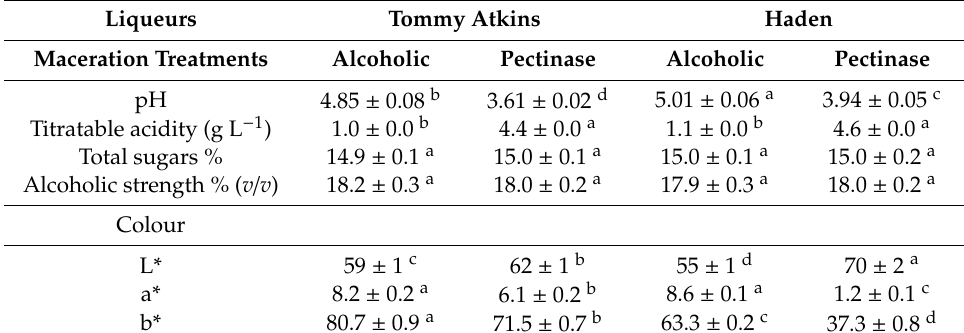
Table 1. Physicochemical analysis and color by CIE L*a*b* system of mango peel liqueurs produced by di ff erent methods of